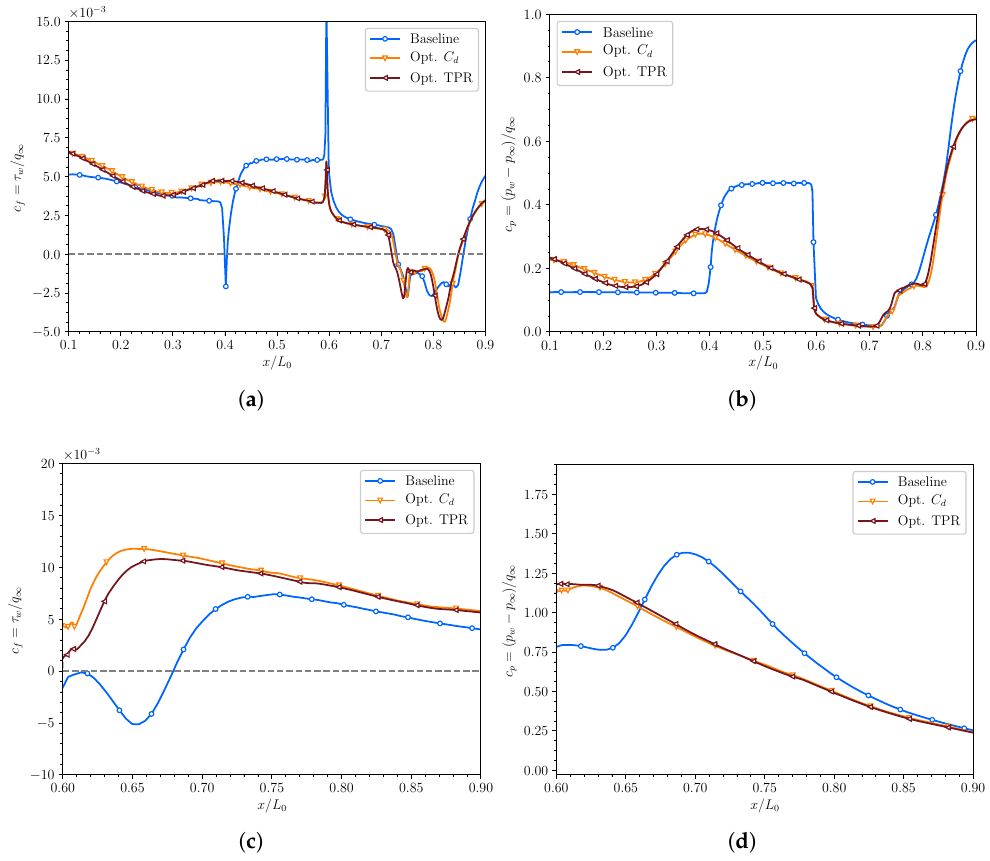
Figure 13. Comparison between the baseline and the optimal f 1 / f 3 friction and pressure coefficient trends along the bottom and the top surfaces. ( a ) Friction coefficient (bottom surface); ( b ) Pressure coefficient (bottom surface); ( c ) Friction coefficient (top surface); ( d ) Pressure coefficient (top